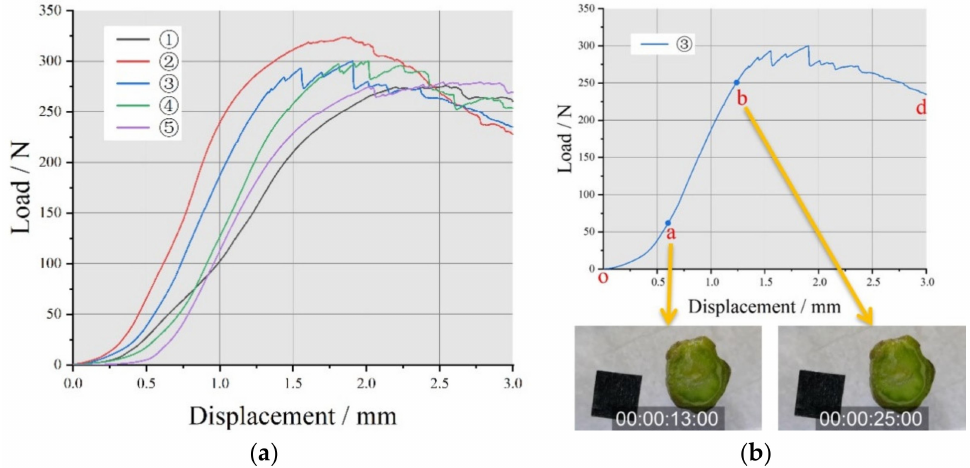
Figure 3. ( a ) The compression load-displacement curves of five stem specimens. ( b ) The schematic diagram for finding the image of the corresponding moment.